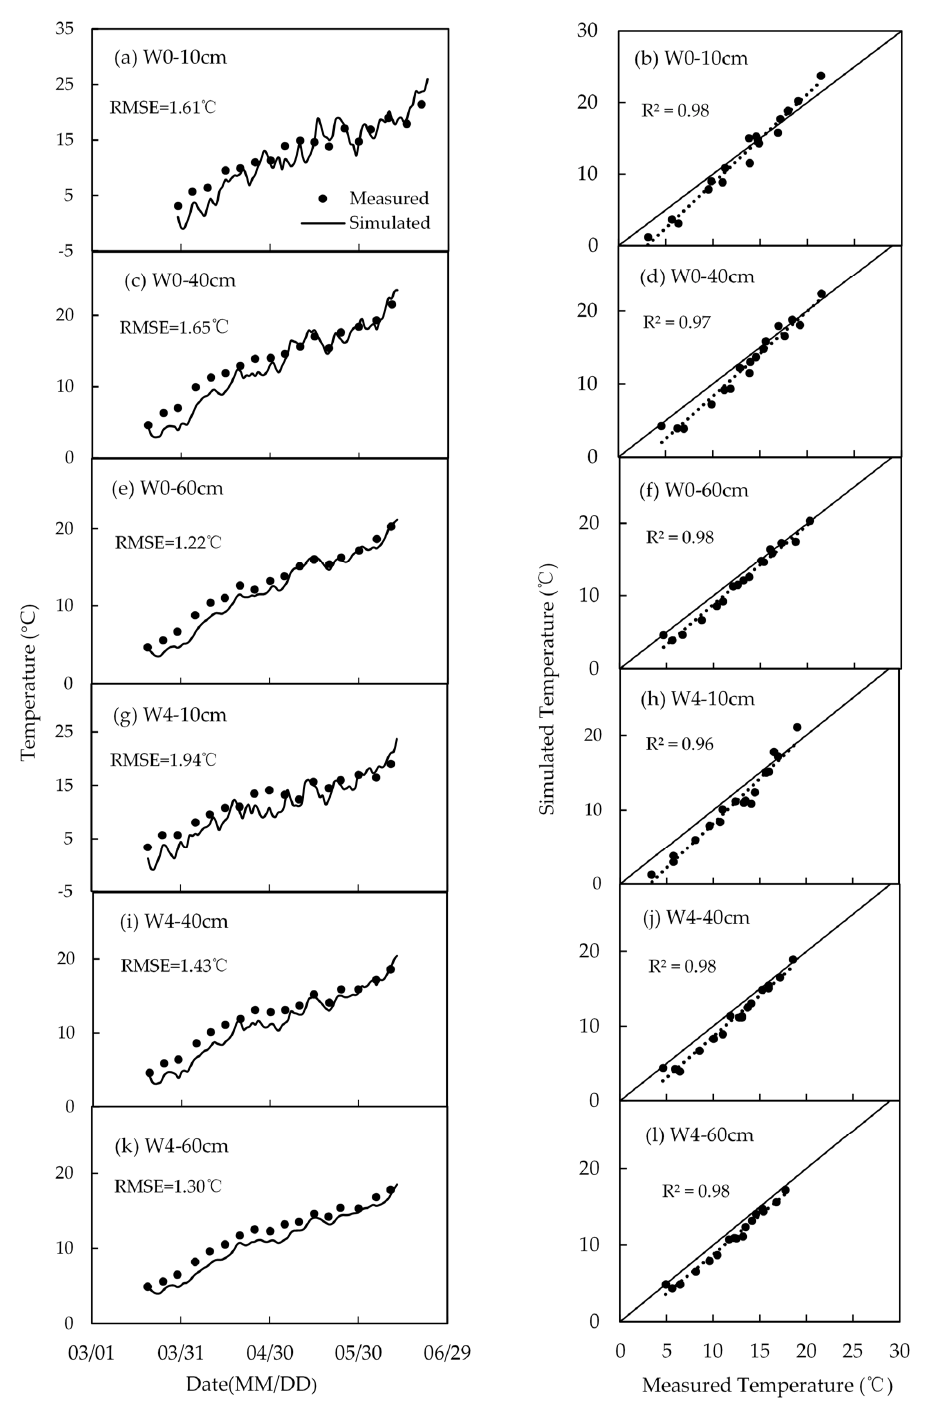
Figure 11. Comparison between simulated and measured soil temperature at soil depth 10 cm, 40 cm, 60 cm under different water